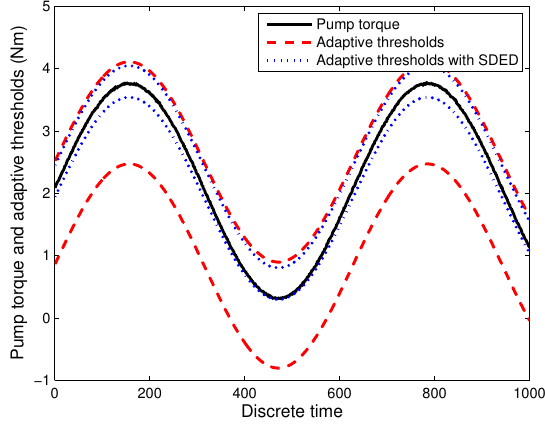
Figure 10. Real pump torque and the corresponding adaptive thresholds obtained with and without SDED for the fault-free case.